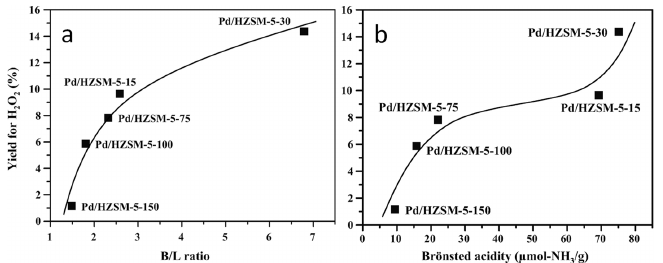
Formatted: Not Highlight Figure 23. ( a ) Correlation between yield for hydrogen peroxide over Pd/HZSM-5-X (X = 15, 30, 75,